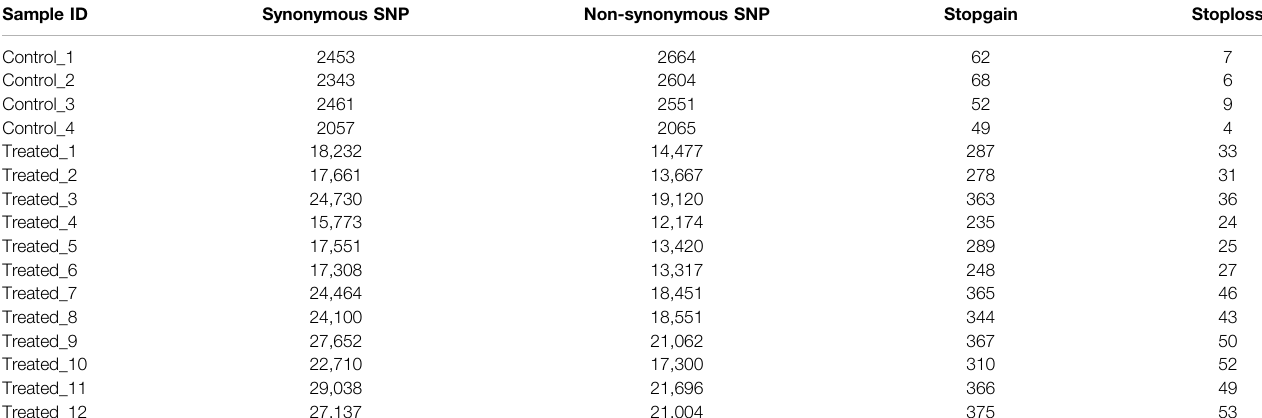
TABLE 6 | SNP mutation types in the control and EMS treatment groups.